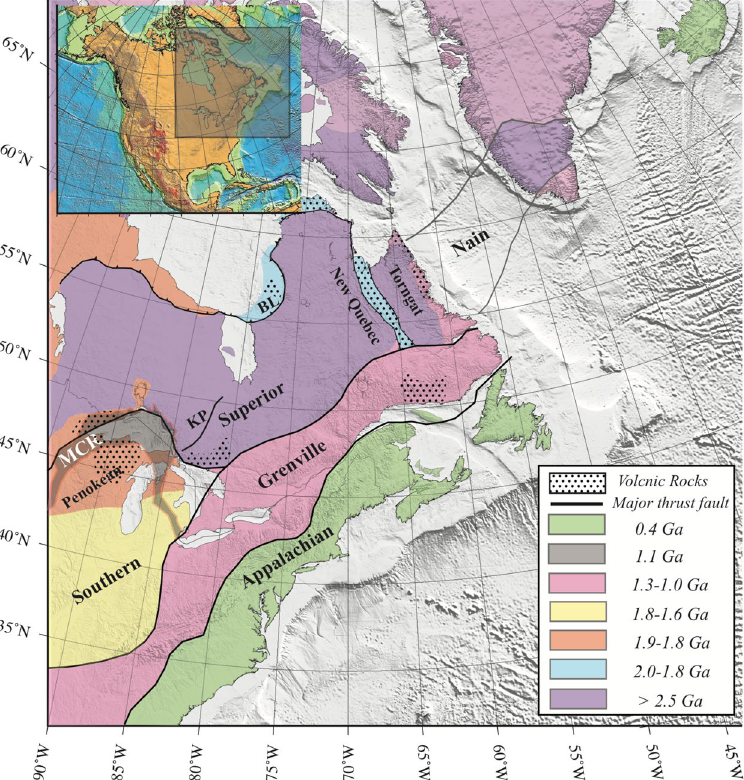
Figure 1. The essential geological blocks of eastern Canada. The Mid-Continent Rift (MCR) is shown by the gray shaded area. Solid black lines show boundaries of geological blocks. Abbreviations are Belcher thrust- fold belts (BL) and Kapuskasing Uplift (KP). Numbers are associated to the locations of Q anomalies in the tomography results. The figure is generated from GMT, which is an open source software available at: http://